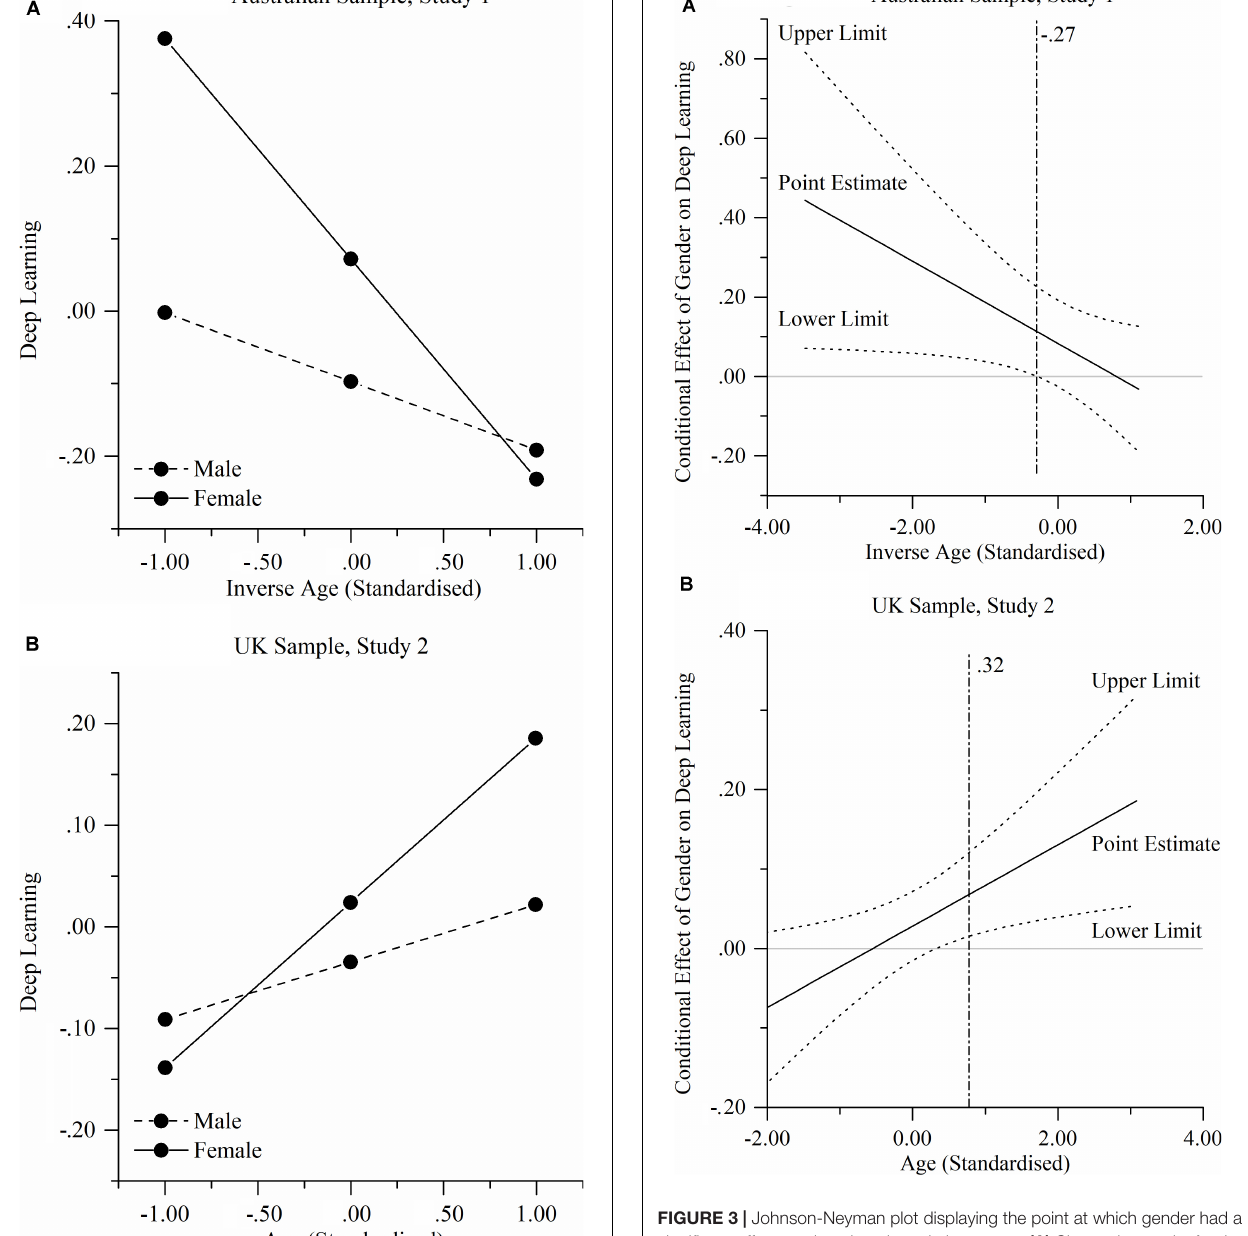
FIGURE 3 | Johnson-Neyman plot displaying the point at which gender had a significant effect on deep learning relative to age. (A) Shows the results for the Australian sample, and (B) demonstrates the results for the United Kingdom sample. Upper and lower limits refer to 95% confidence interval (CI) bounds at values of the moderator